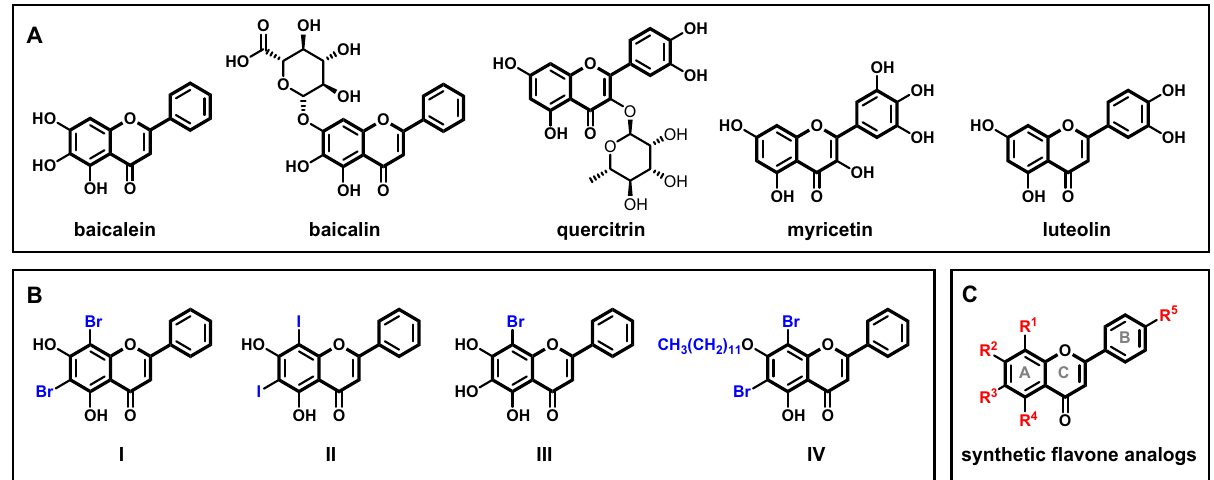
Figure 1. ( A ) Example of natural flavones with anti-dengue activities. ( B ) Previously reported synthetic flavone analogs and ( C ) This